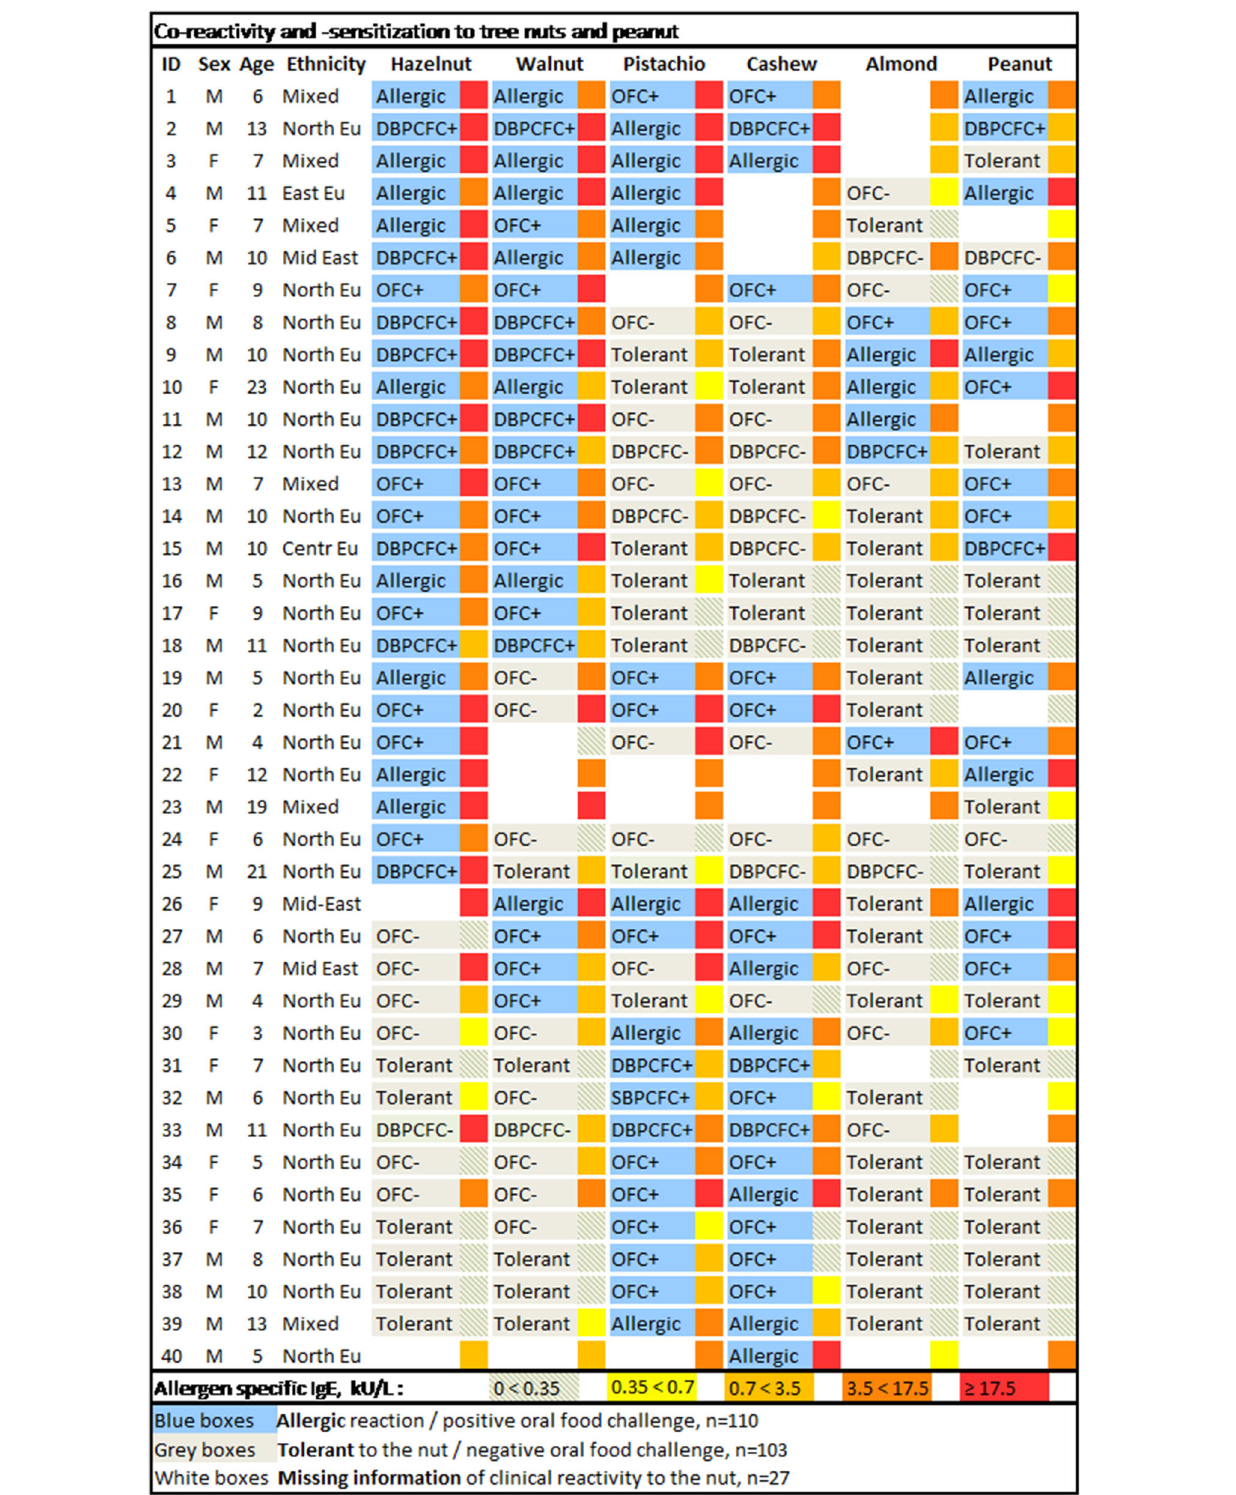
Frontiers in Allergy |